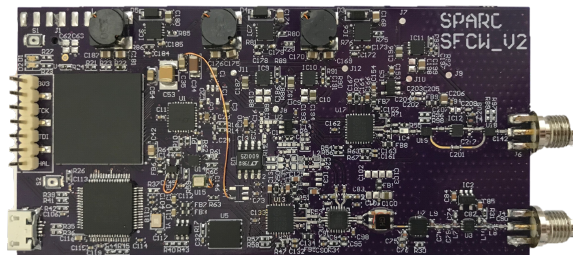
Figure 8. Developed SFCW GPR